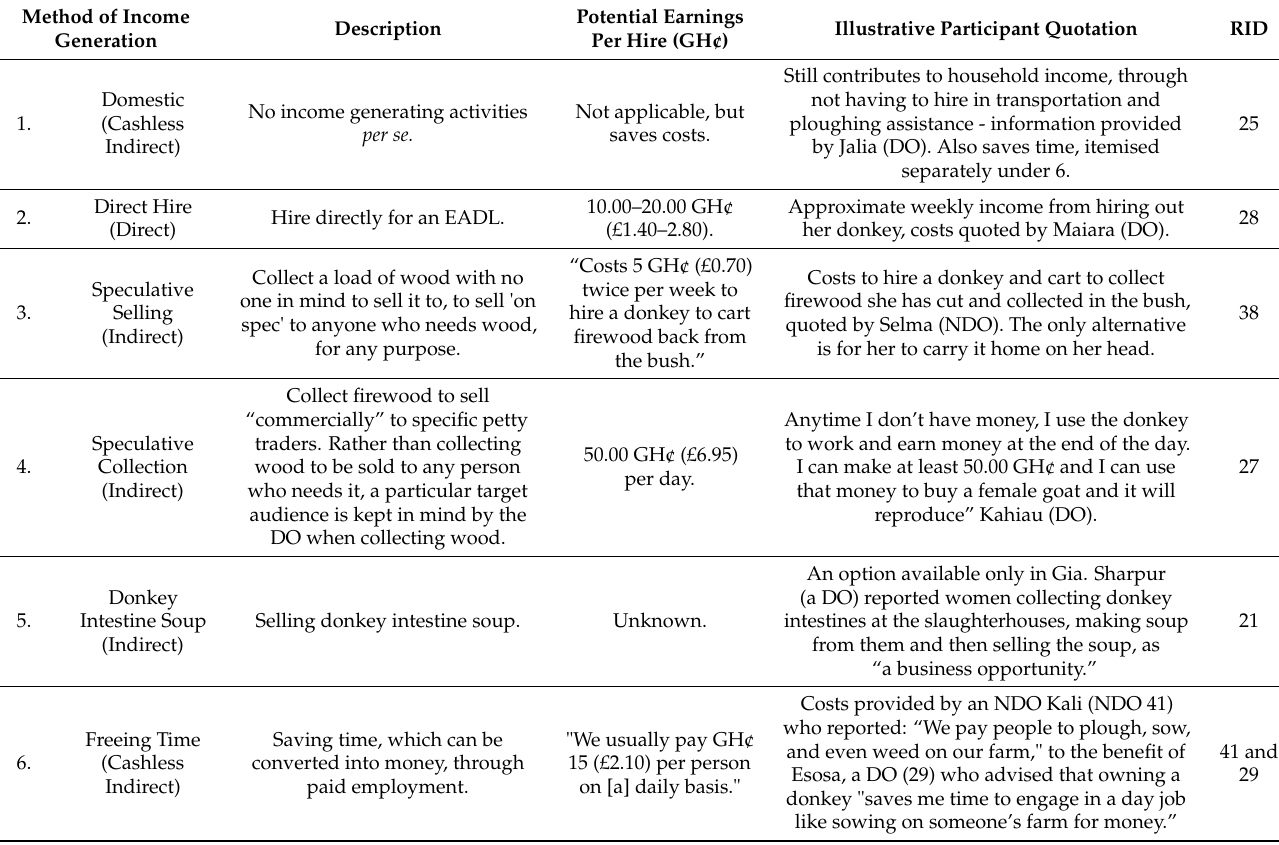
Table 2. The six income benefits conferred through donkey